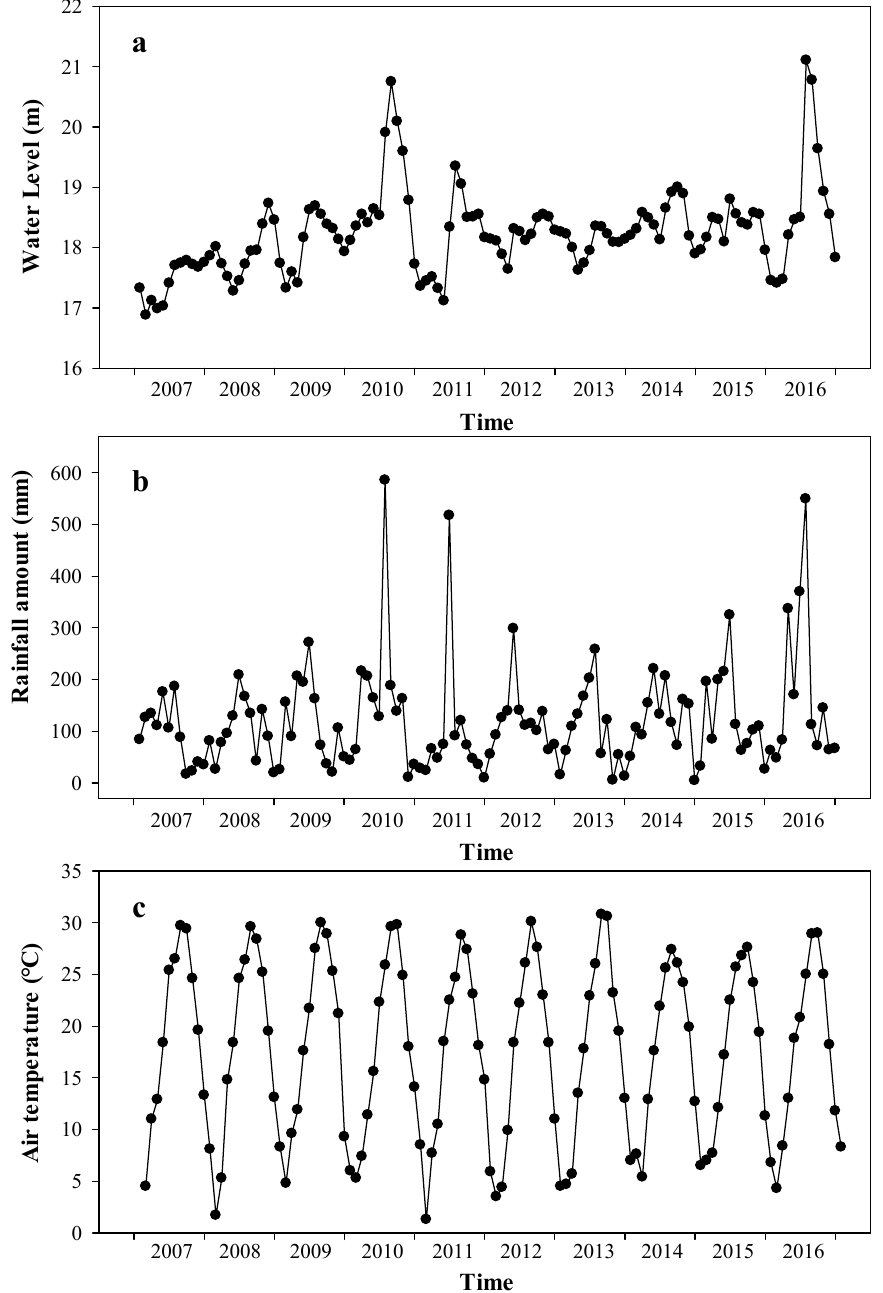
Figure 9. Variation in ( a ) monthly mean water levels, ( b ) monthly rainfall amounts, and ( c ) monthly mean air temperature in Lake Liangzi from 2007 to 2016.